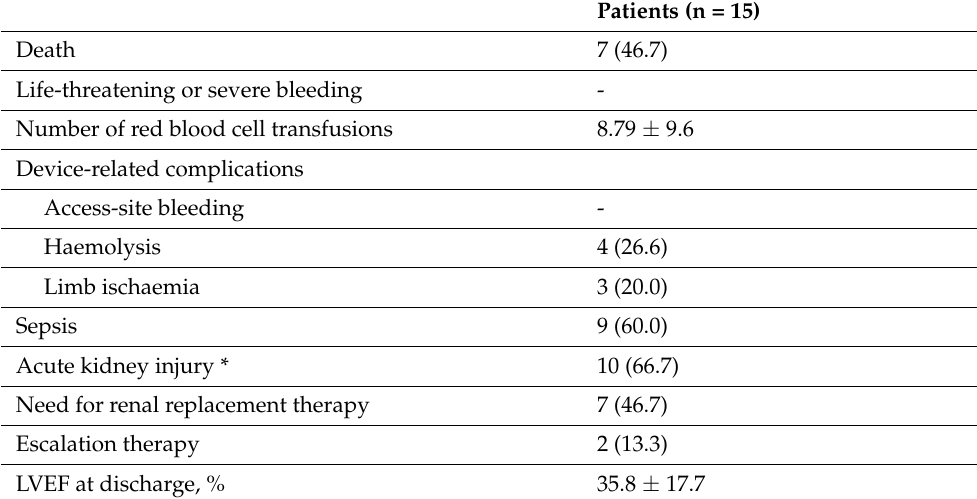
Table 4. In-hospital outcomes.